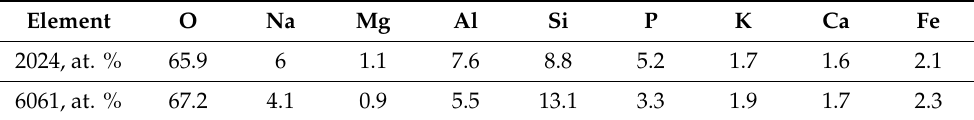
Table 2. Elemental composition of the surface layers on Al 2024 and 6061 alloys.